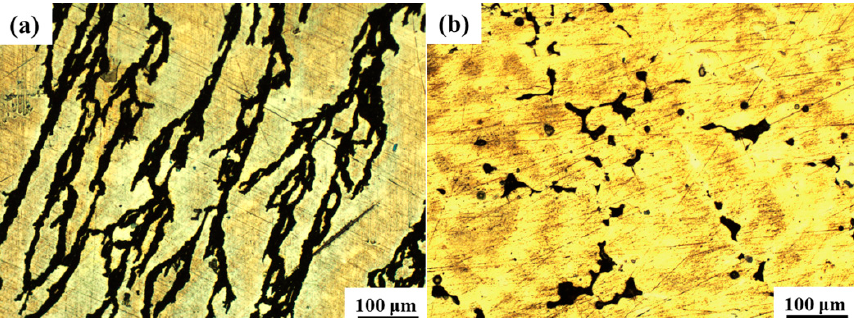
Figure 5. Surface corrosion morphologies of the uncoated AZ31 ( a ) and AZ91 ( b ) Mg alloys after 20 min immersion in 0.1 M NaCl solution.